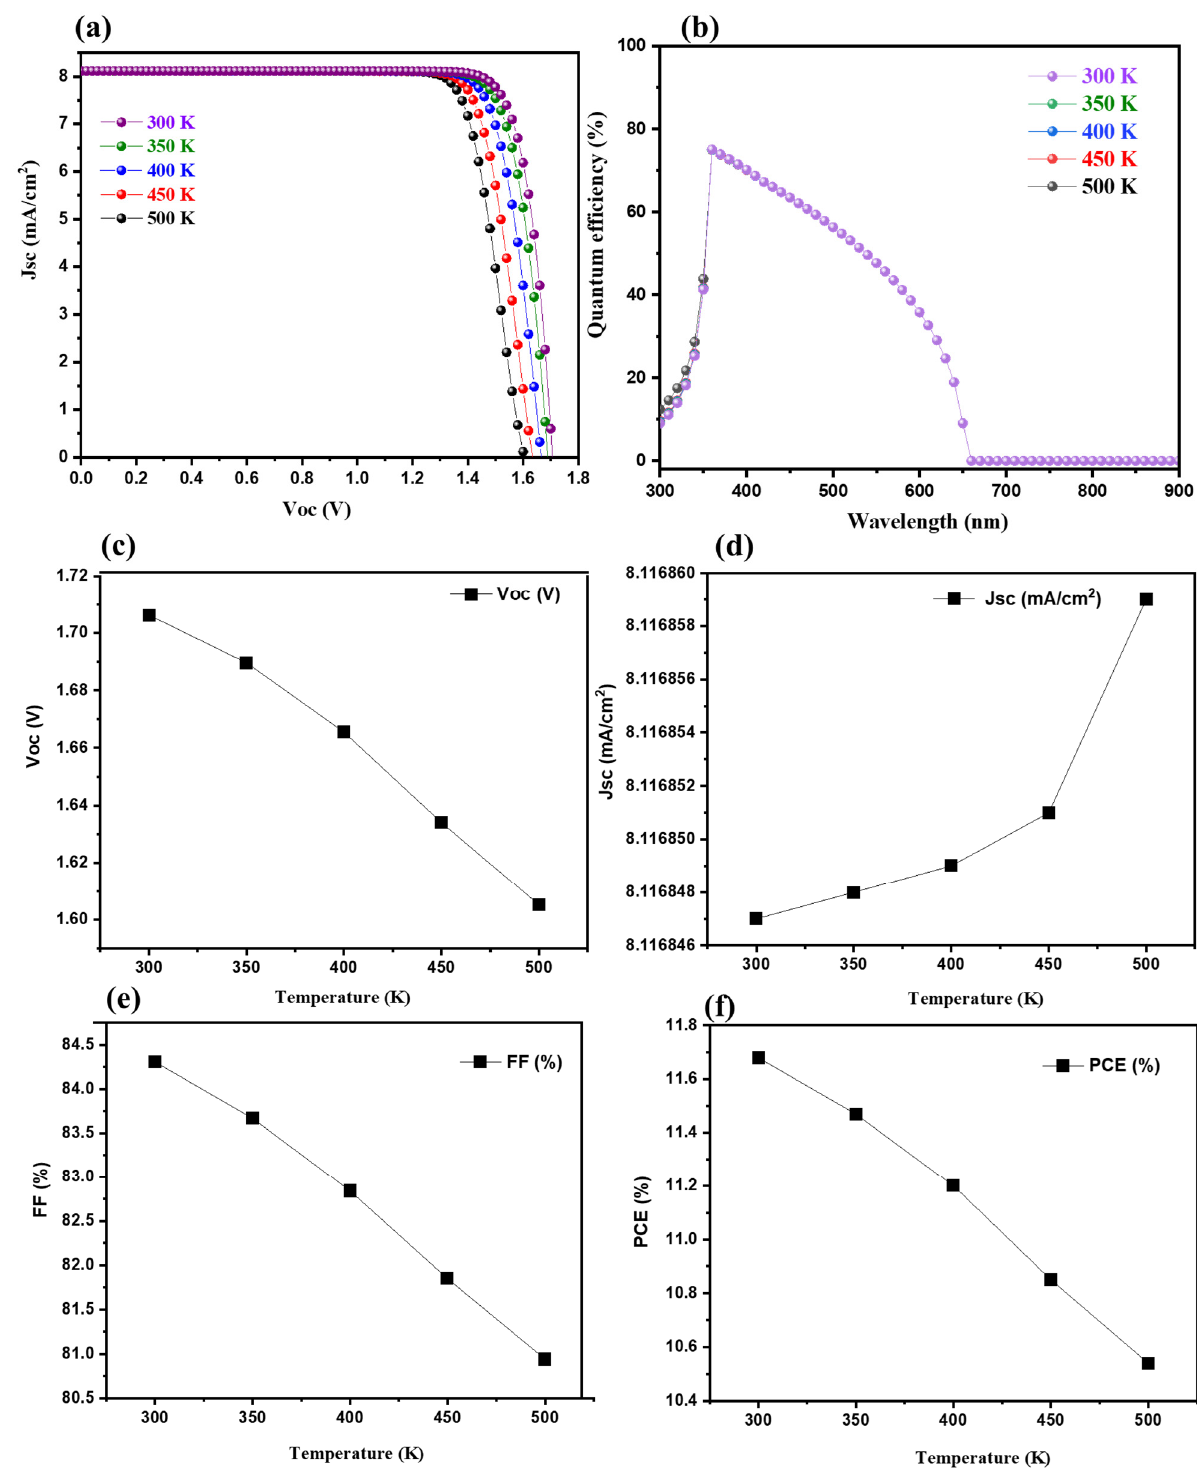
Figure 2. J-V curves ( a ) and EQE curves ( b ) of the simulated PSCs (FTO(500 nm)/SnO 2 (100 nm)/MAGeI 3 (150 nm)/spiro-OMeTAD(100 nm)) at different temperatures (300–500 K). Extracted Voc ( c ), Jsc ( d ), FF ( e ), and PCE ( f ) of the simulated PSCs at different temperatures (300–500 K).